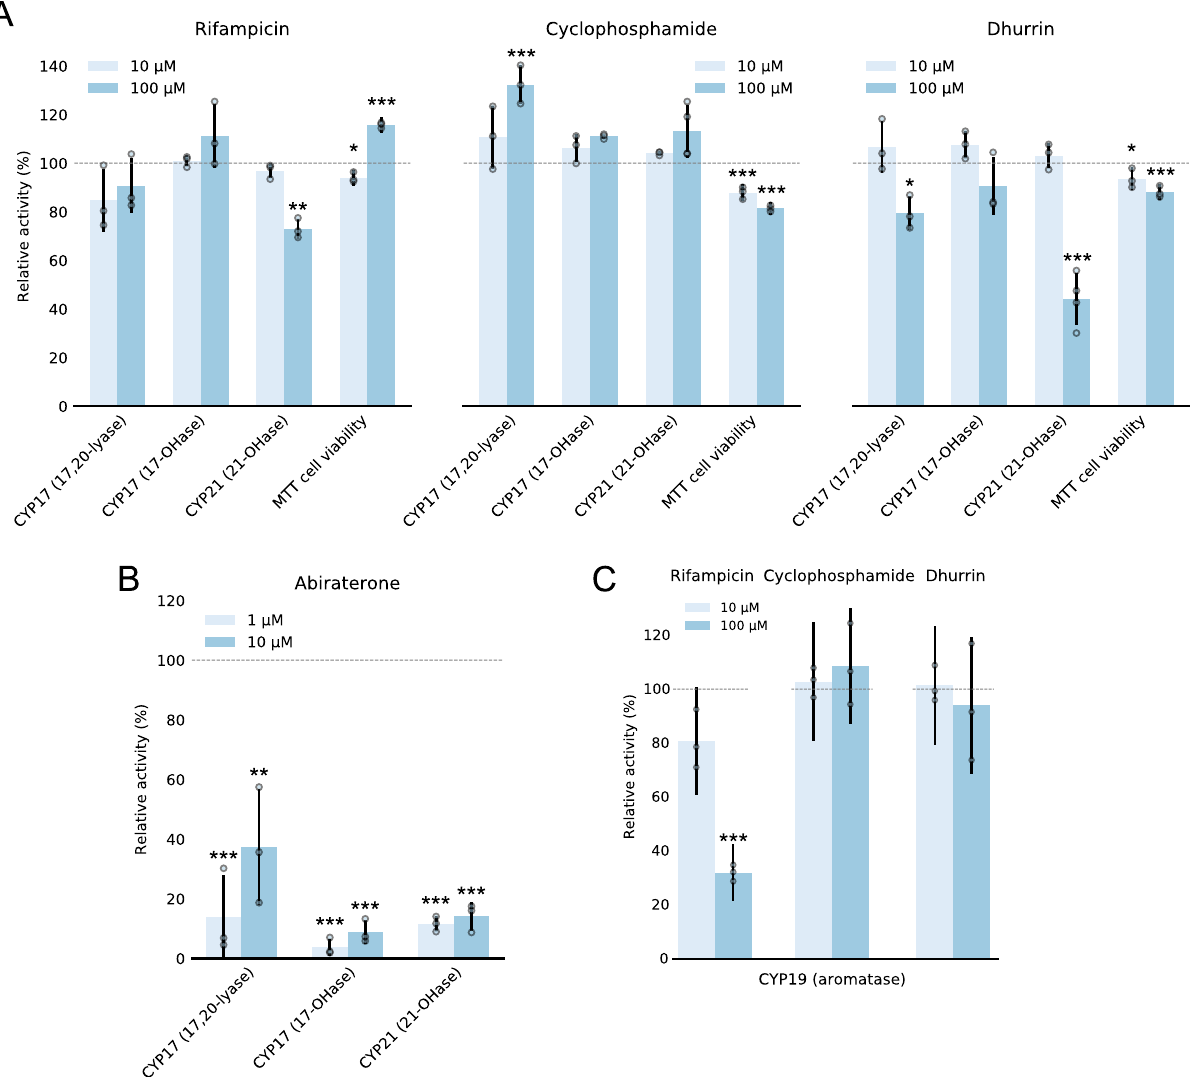
Fig. 5 Biased metabolism: small-molecule ligands bias steroidogenic CYP-activities in human cells and microsomes. A A human adrenocortical cell line (NCI-H295R) was used to assess the effect of small-molecule ligands on steroidogenic CYP17A1 and CYP21A2 hydroxylase activity, and CYP17A1 lyase activity, using radiolabeled substrates (see Supplementary Methods and Supplementary Table 4). Cell viability was assessed based on MTT reduction. Rifampicin shows a small inhibiting effect towards CYP21A2. The cells display increased MTT reduction indicating increased reductase activity. No signi fi cant effects on CYP17A1 activities are observed. Cyclophosphamide causes a signi fi cance increase in CYP17A1 lyase and less signi fi cant towards 17- OHase and 21A2 activities, while MTT reduction decreases slightly. Dhurrin causes inhibition of both CYP17A1 and CYP21A2 activities. B Abiraterone was used as a control inhibitor of CYP17A1 and CYP21A2 in H295R cells. C The effect of ligands on CYP19A1 activity was assessed on microsomes from a human choriocarcinoma cell line (JEG3). Rifampicin shows a concentration dependent inhibitory effect on CYP19A1 activity (32 ± 11% of control). Cyclophosphamide and dhurrin display no signi fi cant effect. A , C Error bars represent mean ± SD of 3 – 4 biological replicates normalized to DMSO controls with propagated error. See Supplementary Fig. 14 for raw data and Supplementary Table 4 for exact value of n for each experimental condition. Note, overlapping data points appear shaded. Level of signi fi cance is determined by one-way ANOVA and Tukey ’ s HSD test correcting for multiple comparisons (* p < 0.05; ** p < 0.01; *** p < 0.005; see Supplementary Methods for details). Source data are provided as a Source Data fi